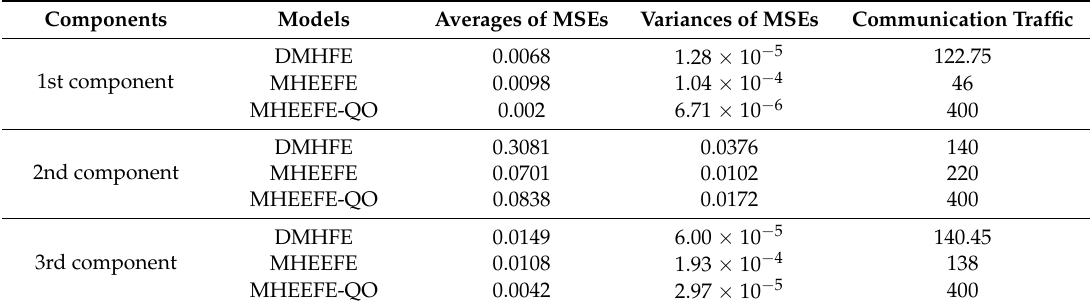
Table 2. Some statistical data and communication traffics for each component with different models.